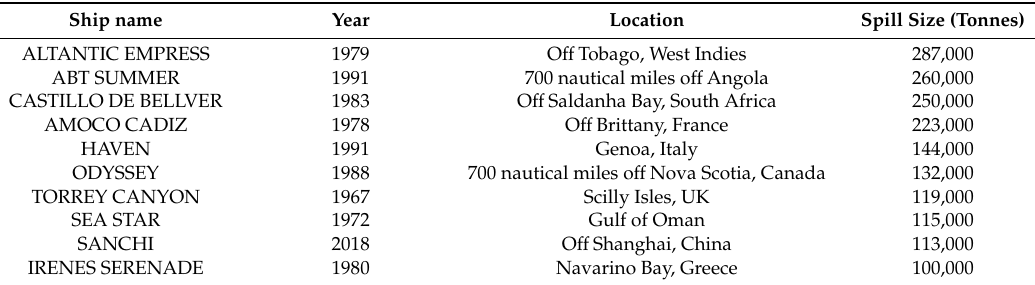
Table 5. The 10 selected significant oil spill events since